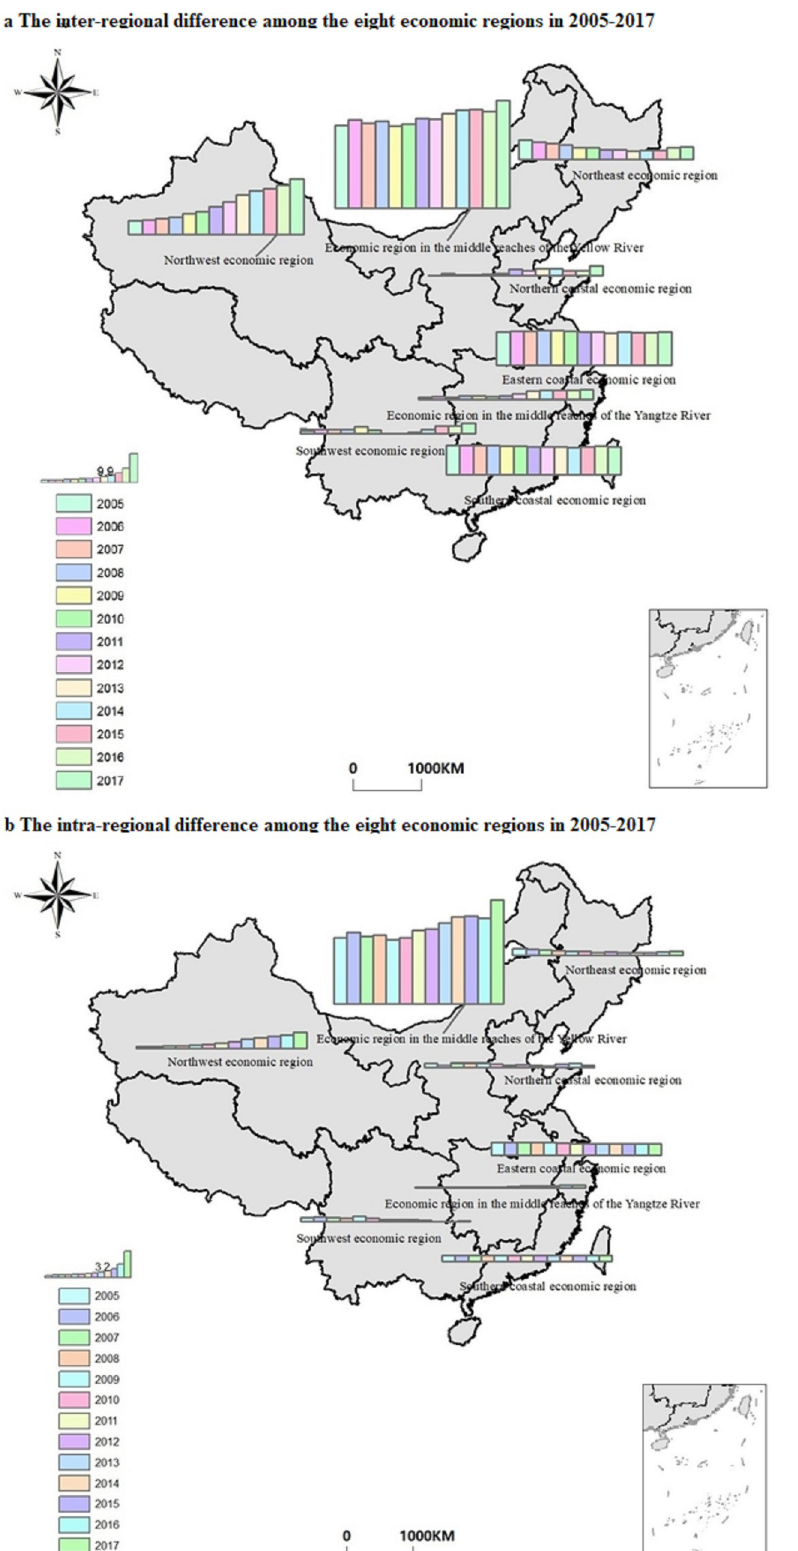
Fig 6. Inter-regional and intra-regional differences in China’s eight economic regions.